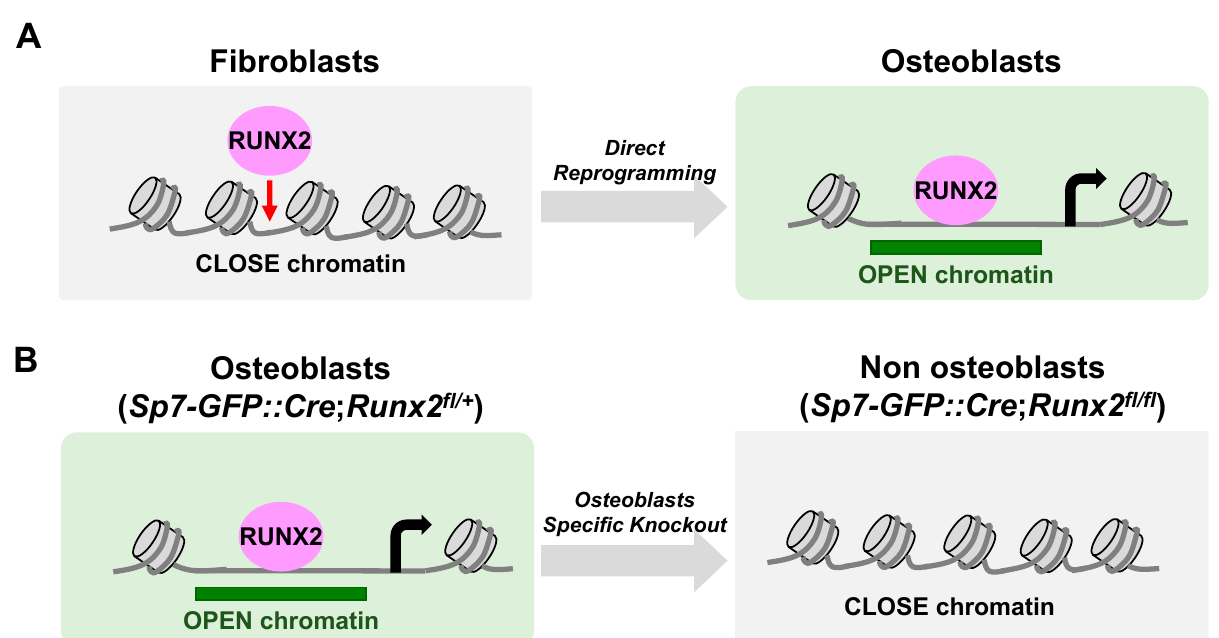
Figure 4. Dynamics of chromatin accessibility by alteration of Runx2 expression. ( A ) Exogenous Runx2 expression enhances chromatin accessibilities via osteoblast direct reprogramming. ( B ) Runx2 ablation using Sp7 ‐ GFP::Cre with Runx2 ‐ flox decreases chromatin accessibility in the neonatal osteoblasts of mice.